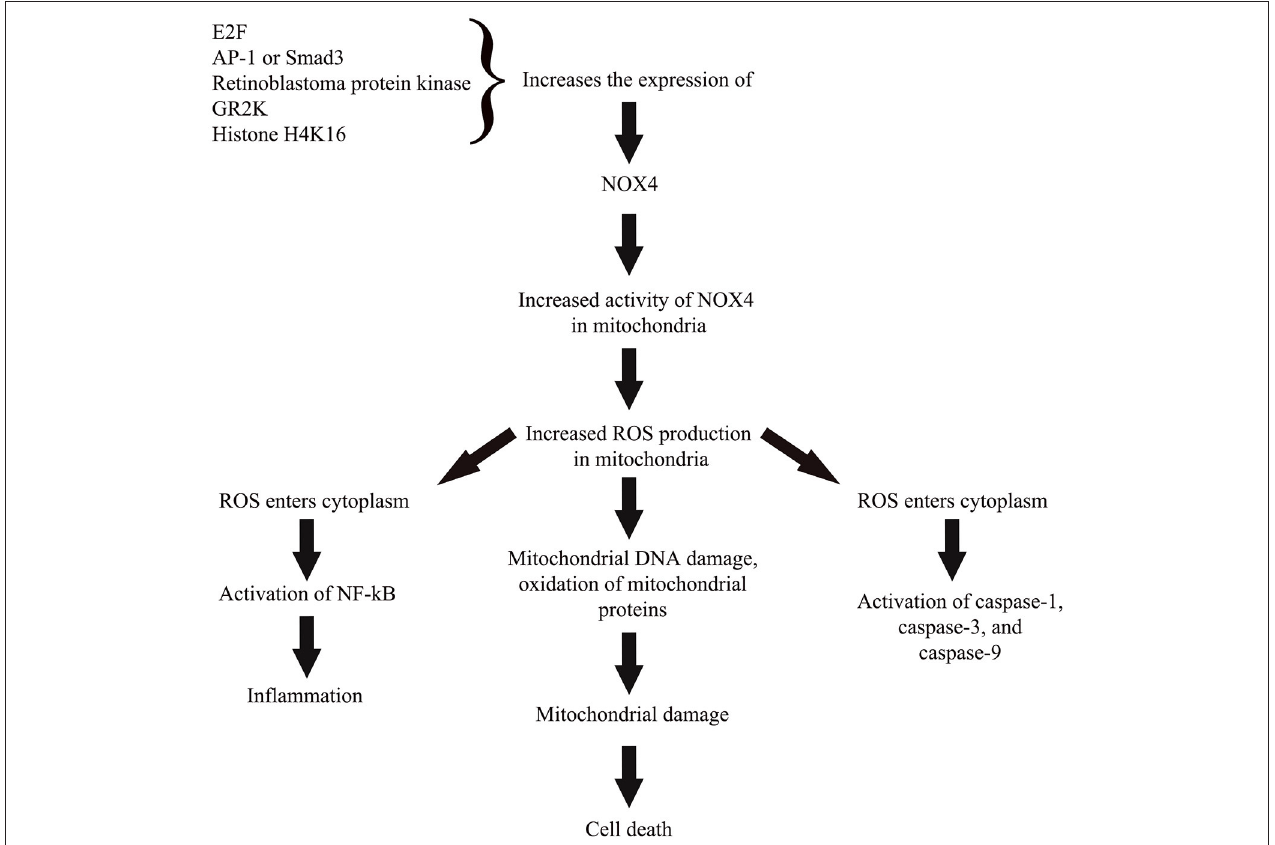
FIGURE 2 | A simplified representation on the role of NOX4 in cellular pathway toward ROS-induced oxidative stress. Activity of NOX4 is regulated through regulation of the enzyme’s expression by various transcription factors, protein kinase, cellular receptor, and epigenetic regulator. Enhanced NOX4 expression or activity in mitochondria leads to increased ROS production that subsequently causes mitochondrial damage and cell death. Excess ROS also likely to travel toward cytoplasm and activate numerous pro-apoptotic proteins and also activate nuclear factor kappa beta to trigger a pro-inflammatory state of the